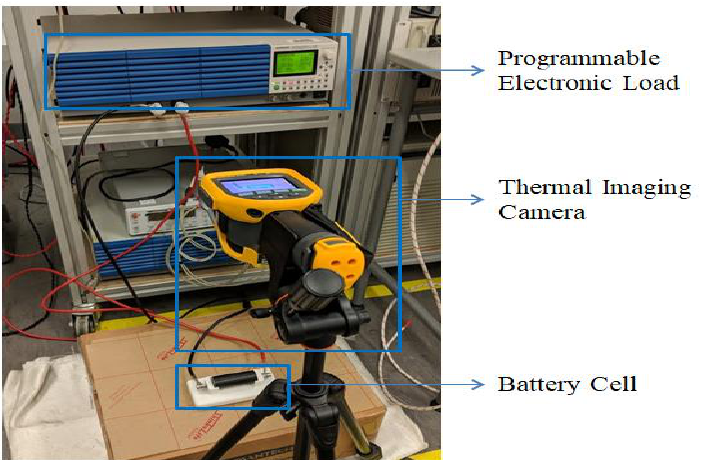
Figure 11. Schematic of experimental setup.